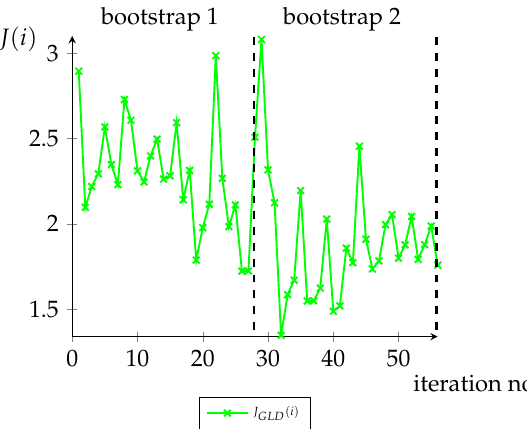
Figure 20. Time course from the real-world experiment (Exp. no. 1): tuning of the altitude controller during the UAV flight with an additional (heavy) mass (225 g).